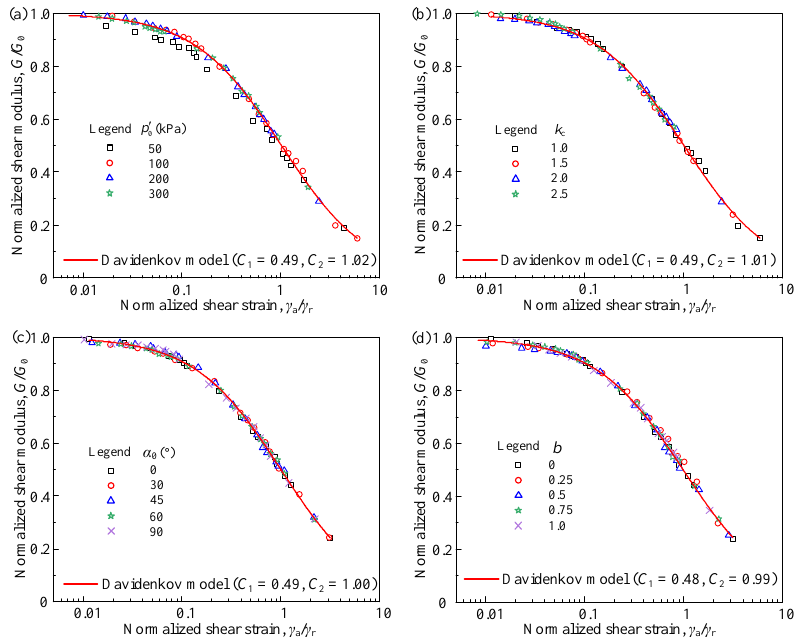
Figure 12. G / G 0 versus γ a / γ r curves of isotropically and anisotropically consolidated saturated coral sand for the undrained cyclic torsional shear tests under various ( a ) effective mean principal stress, ( b ) consolidation ratio, ( c ) consolidation direction angle, and ( d ) coefficient of intermediate principal stress.